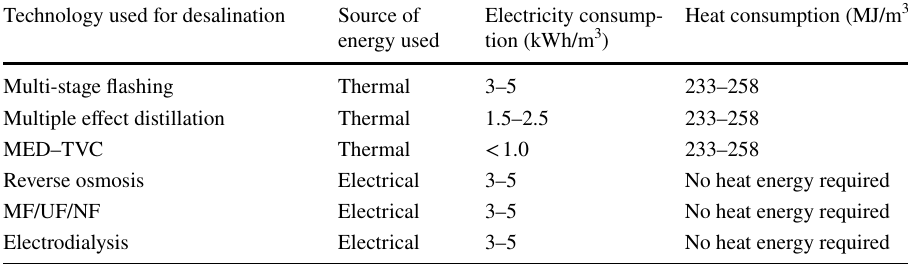
Technology used for